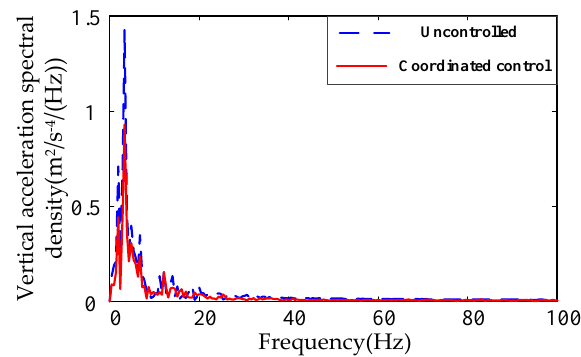
Figure 21. Vehicle vertical acceleration under the straight condition.